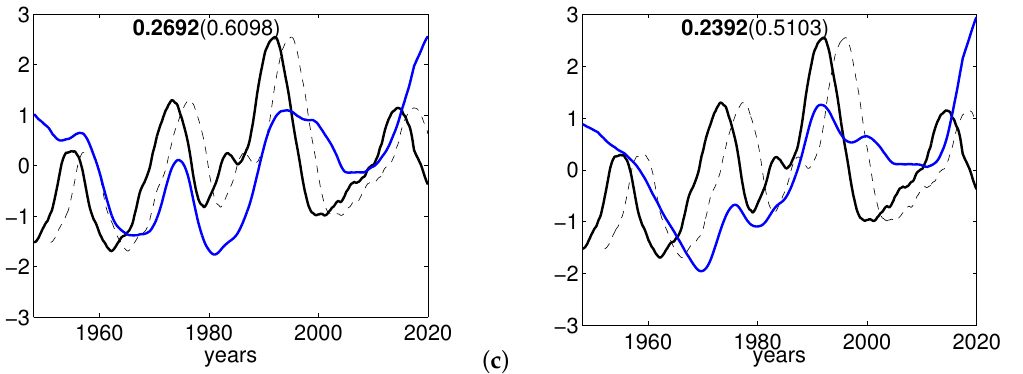
Figure 11. Normalized time variations in the transport of Atlantic waters and heat fluxes from the Atlantic (in σ ) compared with the time variations of the third EOF mode principal component (black), taken with the opposite sign: ( a ) Atlantic water inflow through the Barents Sea (red), σ = 0.75 Sv, ( b ) heat flux from the Atlantic through the Barents opening (red), σ = 20 TW, ( c ) total the inflow rate through the Barents Sea and the Fram Strait (blue), σ = 0.45 Sv, ( d ) total heat flux through the Barents opening and through the Fram Strait (blue), σ = 16 TW, The dashed black line represents the principle component shifted in time by an amount corresponding to the maximum correlation. The first number from the graphs indicates the correlation coefficient of the main series, the second, in brackets, when there is an optimal lag